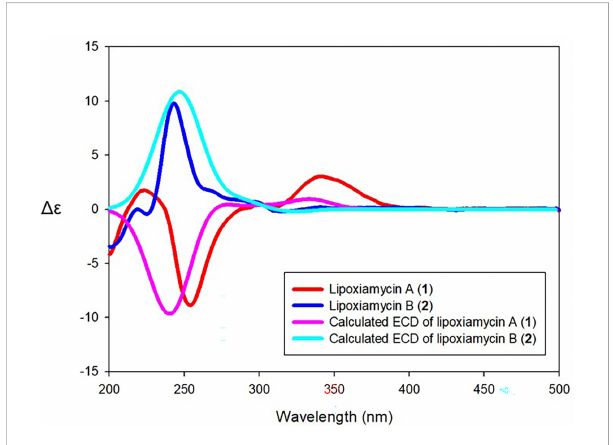
FIGURE 5 Comparison of the experimental and calculated ECD spectra of compounds 1 and 2.